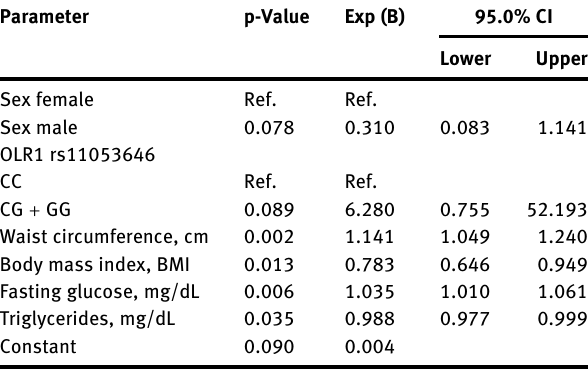
Table  : Investigation of CAD risk factors with logistic regression